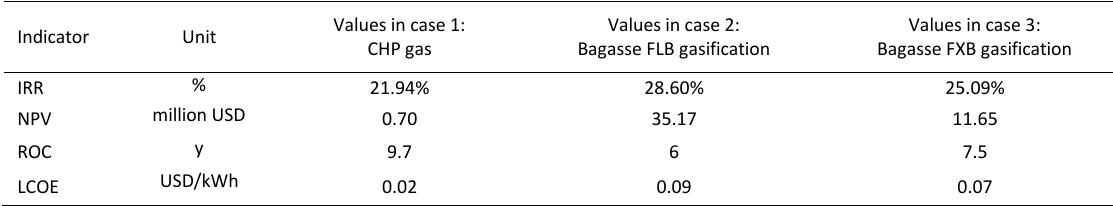
Table 5: Results of economic evaluation of investment plans for the studied cases